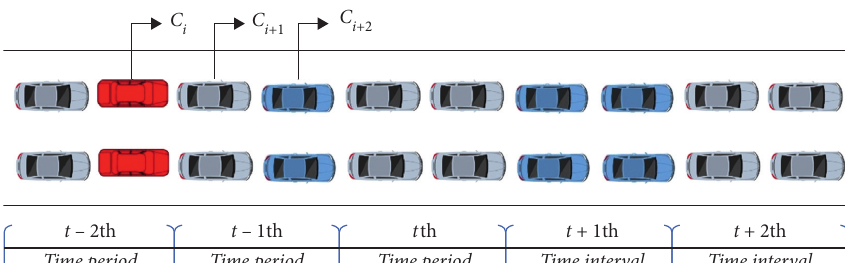
Figure 1: Parking volume forecast model on different parking behaviour